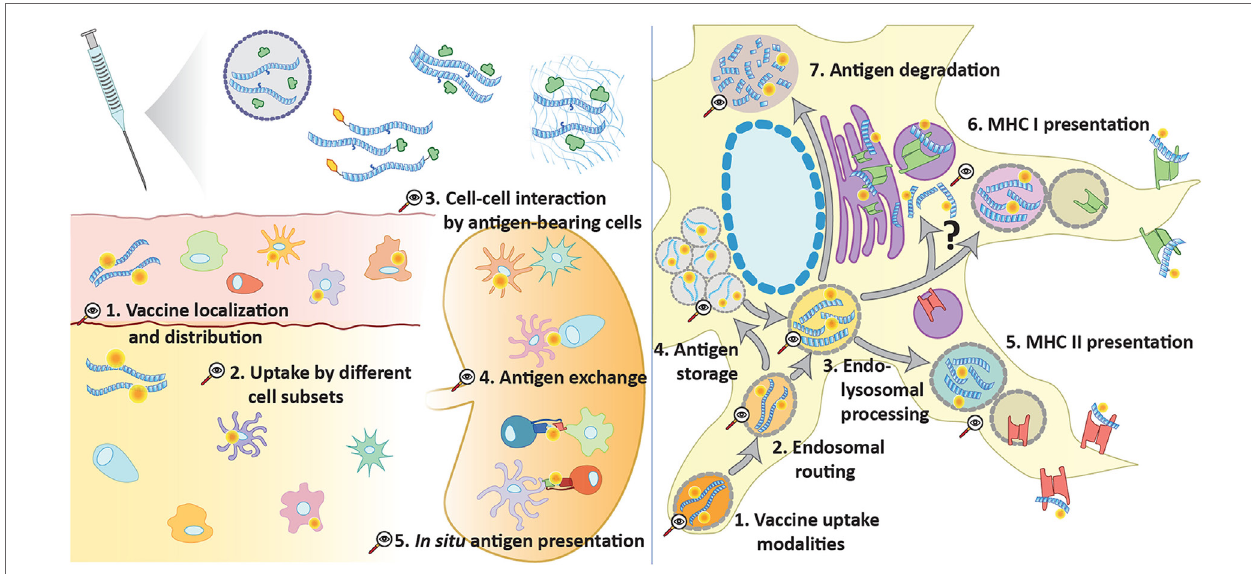
FiGURe 1 | Opportunities for advanced tracking techniques in vaccination. Several forms of peptide antigen can be traced (e.g., via click chemistry) at multiple levels to provide further understanding of vaccine processing and induction of adaptive immunity. At a supracellular level, it can unveil vaccine diffusion, drainage, and the main cellular recipients. Tracking of antigen in different cell types can also help to understand the steps involved in the initiation of an immune response, such as cell–cell interaction, antigen exchange, and in situ antigen presentation. At a subcellular level, peptide tracking is an important tool to explore the intracellular events that lead to antigen presentation following antigen uptake: endosomal trafficking and sorting to storage compartments, class I or class II presentation or